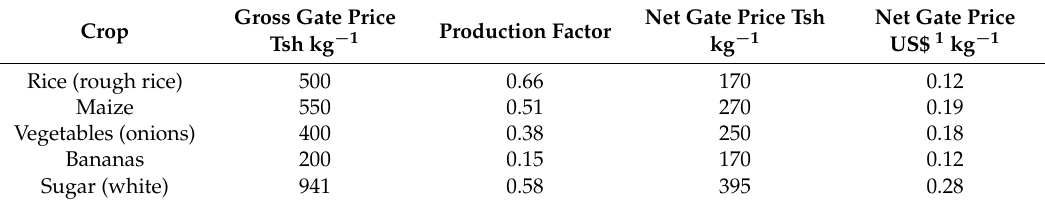
Table 1. Net farm gate prices for crops under irrigation from 2008–2010 in the Upper Pangani River